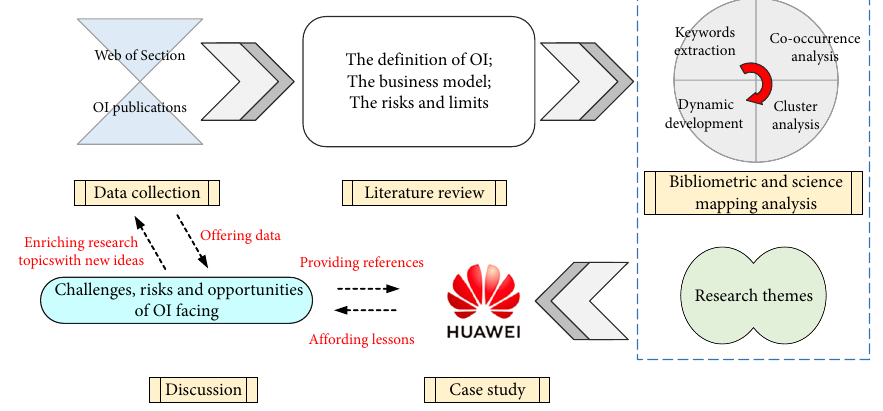
Figure 4. The research framework of this paper